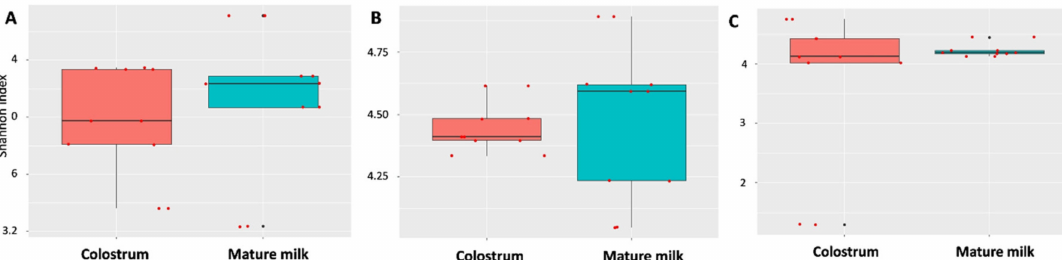
Figure 1. Alpha diversity measured (within sample diversity) by Shannon index, statistical ( p ) value generated by Wilcoxon test. The richness of the alpha diversity bacterial community in mature milk was higher than that in colostrum, but these di ff erences were not statistically significant for farm A ( A ) ( p = 0.84), B ( B ) ( p = 0.84), or C ( C ) ( p = 0.56). The horizontal bars within boxes represent median values, the tops and bottoms of boxes represent 75th and 25th quartile values,